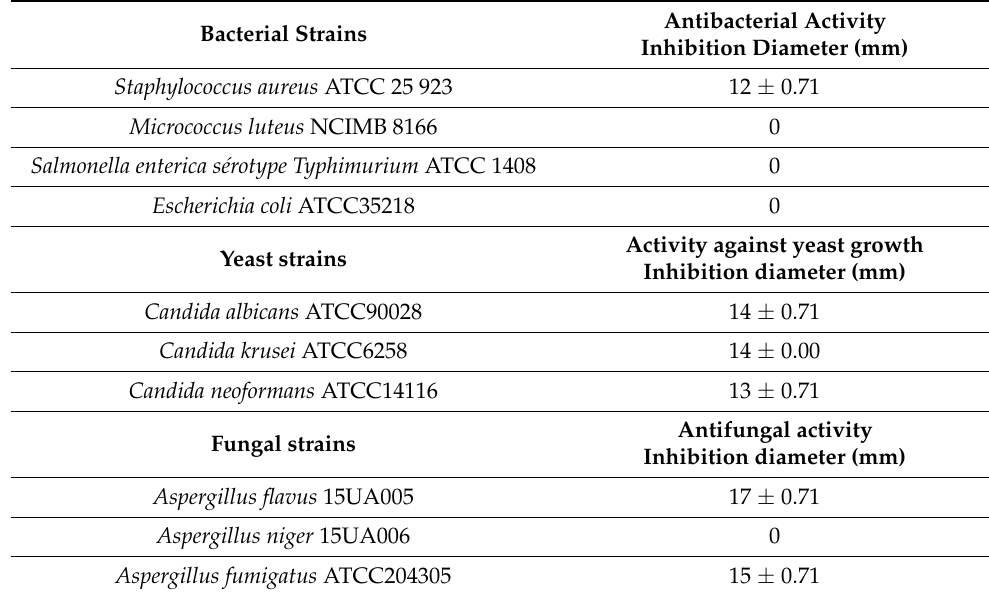
Table 3. Antimicrobial activities of C. siliqua .